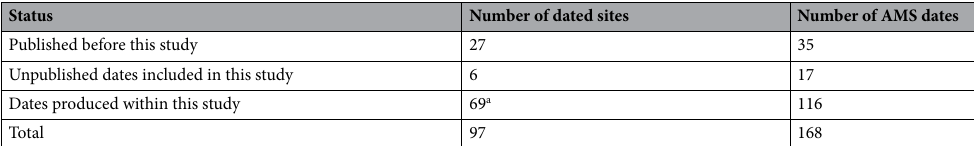
Table 1. The number of published, unpublished and newly produced AMS-dates reported as obtained on broomcorn millet from Europe. Our analysis showed that not all of the ’millet-dates’ were obtained (exclusively on) broomcorn millet (see remarks in Supplementary Dataset). a Includes five sites with published dates, re-dated within this